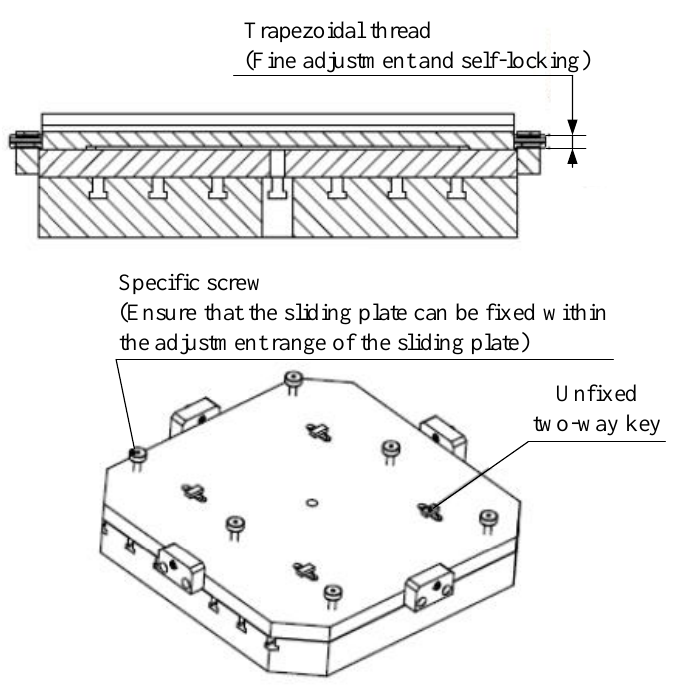
Figure 11. Adjustable base plate.